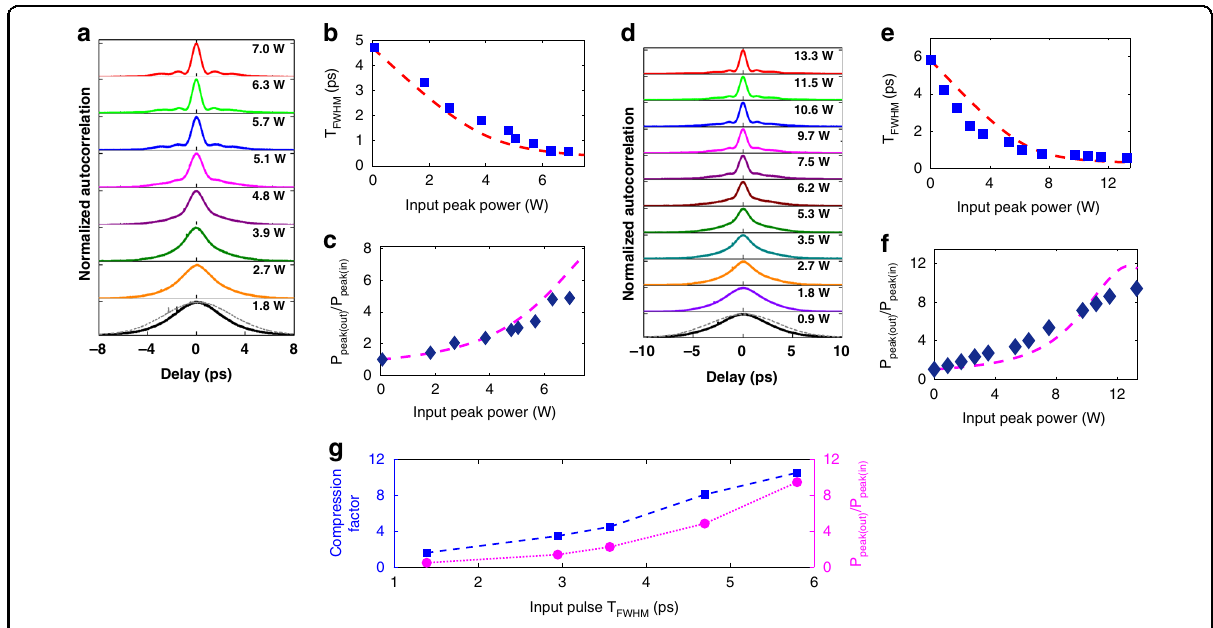
Fig. 4 Temporal compression measurements using the USRN compressor ( Device 1 , β 2(grating) = − 600 ps 2 m − 1 ) designed for high temporal compression. a Measured autocorrelation traces, b measured output pulse T FWHM (blue squares) and c P peak ð out Þ P peak power of 4.7 ps pulses. d Measured autocorrelation traces, e measured output pulse T FWHM (blue squares) and f P peak ð out Þ P function input peak power of 5.8 ps pulses. The numerically calculated T FWHM and P peak ð out Þ P and magenta dashed curves, respectively. The dashed curve at ( e ) is extracted from Fig. 3a. A maximum temporal compression factor of 11× and peak power increase of 9.4× is achieved. g Experimentally measured compression factor and P peak ð out Þ P